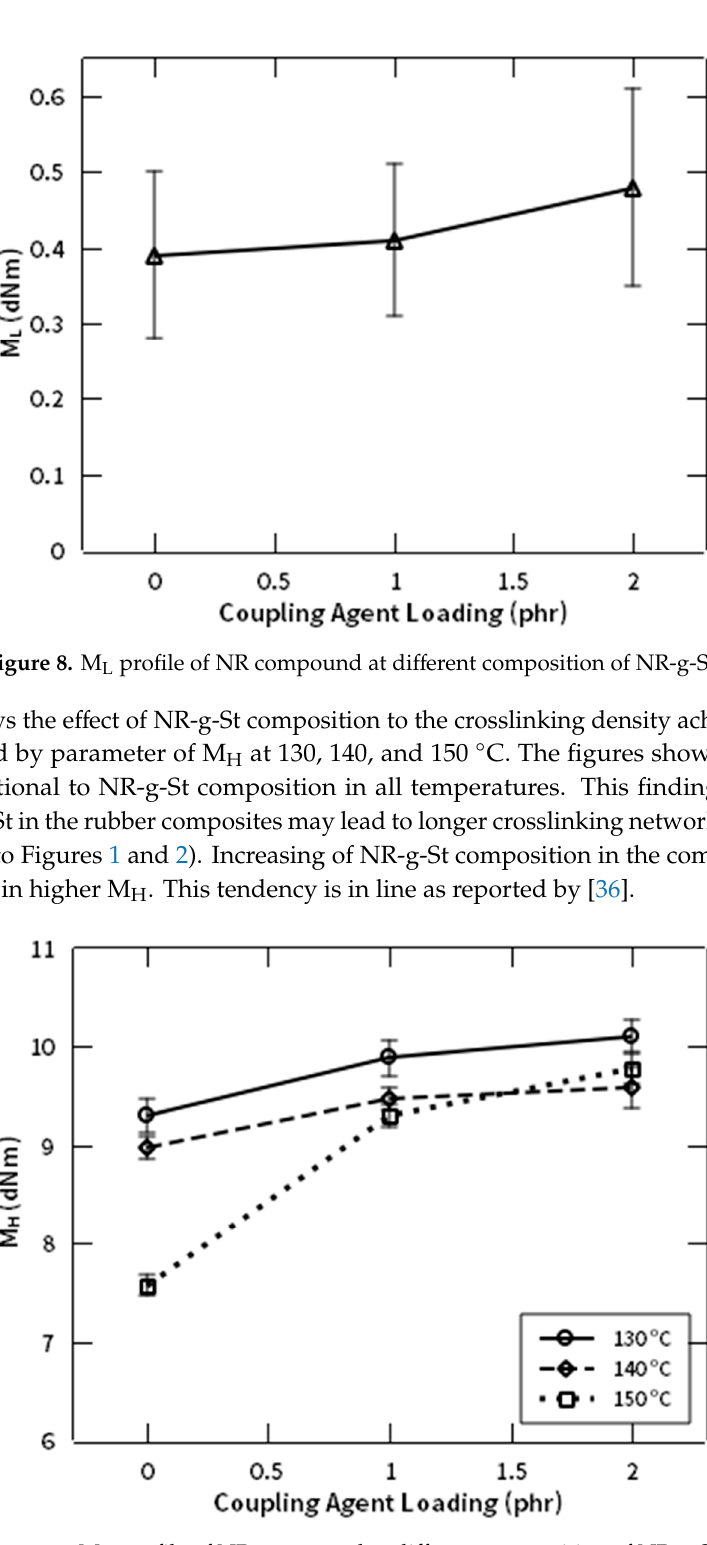
Figure 10. M H -M L profile of NR compound at different composition of NR-g-St. The rheological behavior of NR/NF composites with and without addition of NR-g-St coupling agent were studied by observing the required time to achieve two torque units above M L , as the scorch time (ts 2 ) and optimum crosslinking, as the t 90 , which are shown in Figures 11 and 12, respectively. Figure 11 shows that increasing the composition of NR-g-St in the compound, at the